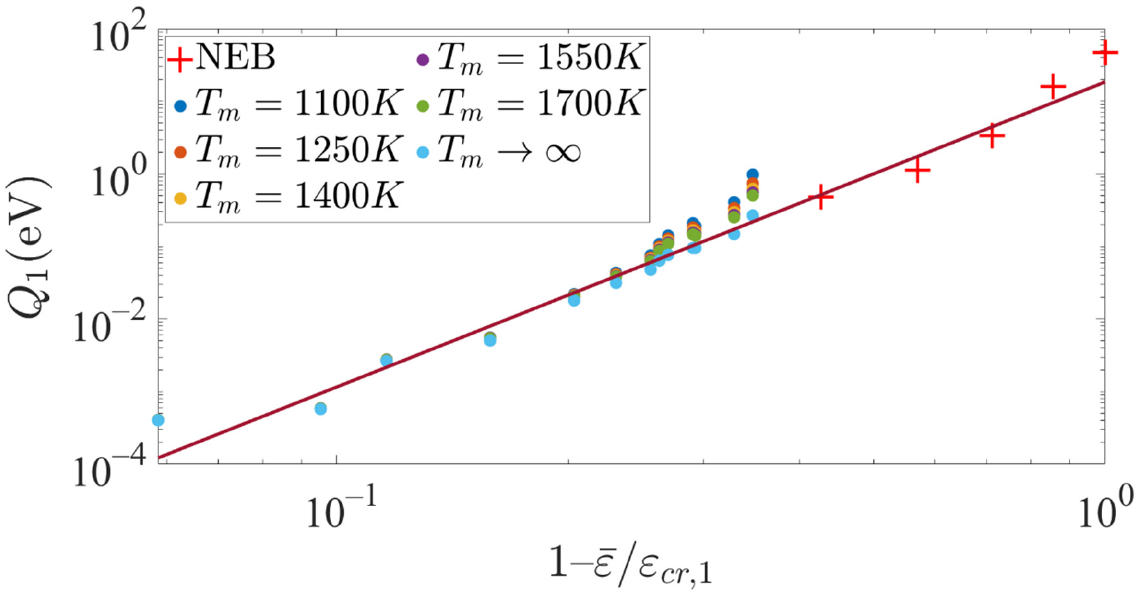
⁄ (cid:3439) . ) (cid:3117) 1